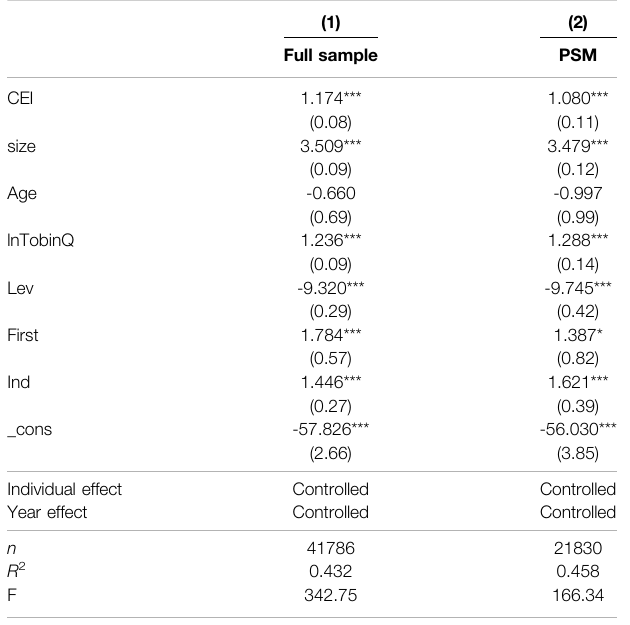
TABLE 7 | Baseline regression results.